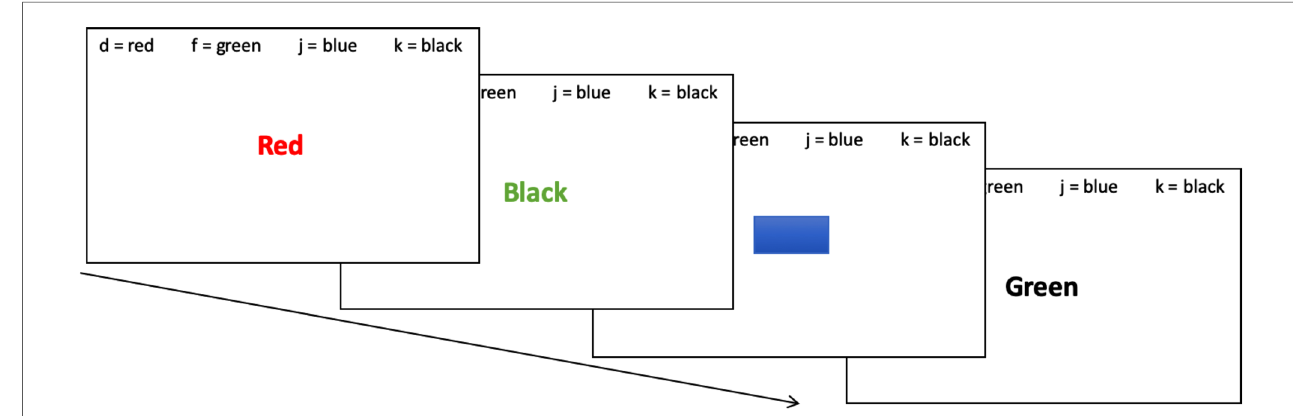
FIGURE 2 Stroop test on a computer set-up. The Stroop Color Word Test was held on a computer. In a test trial, congruent (color word and the color it is presented in are the same), incongruent (color word and the color it is presented in are not the same) and neutral items (colored rectangles in red, green, blue or black) were shown. After a test trial, the 3-minutes experimental trial with 84 randomly sampled items started.